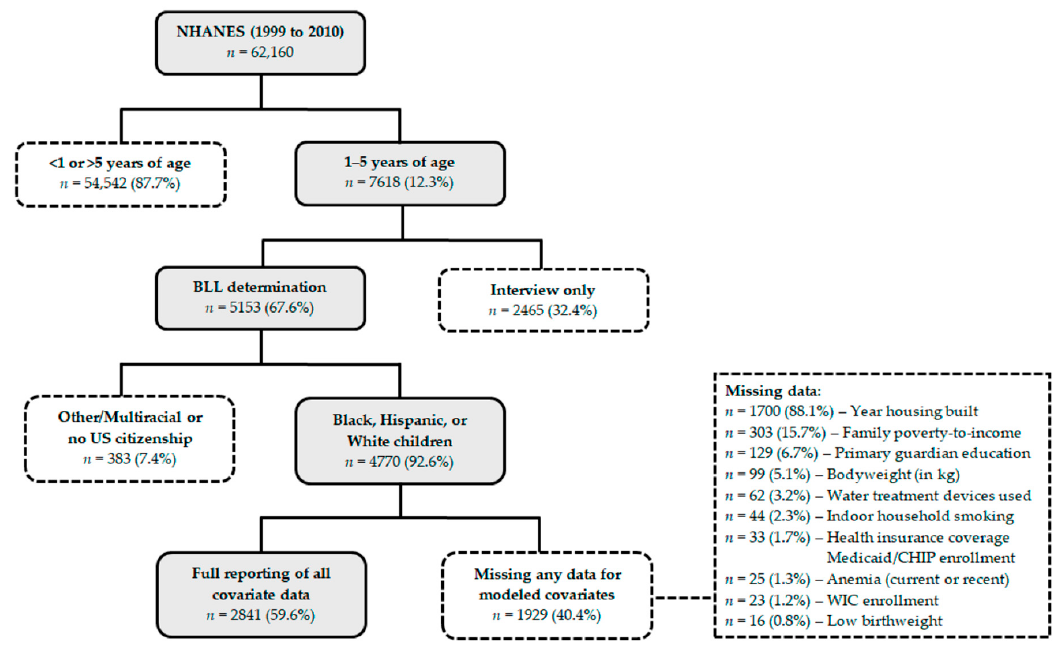
Figure 1. Case selection schematic for exclusion or inclusion in the studied